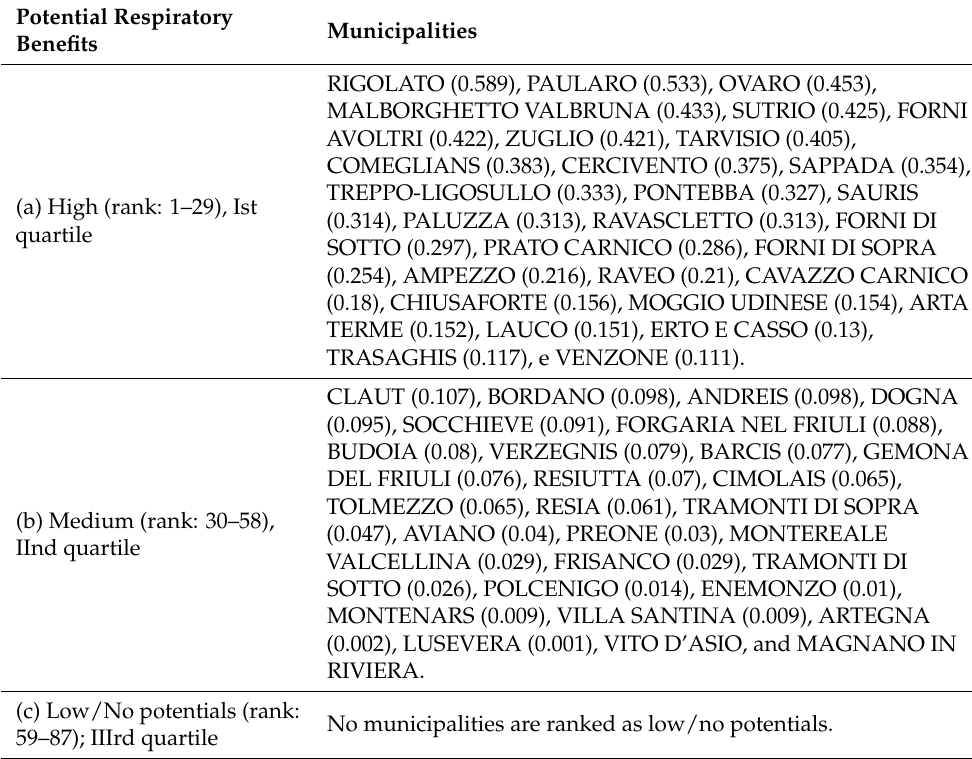
Table 6. Potential respiratory benefits of forest heritage by municipality through applying model